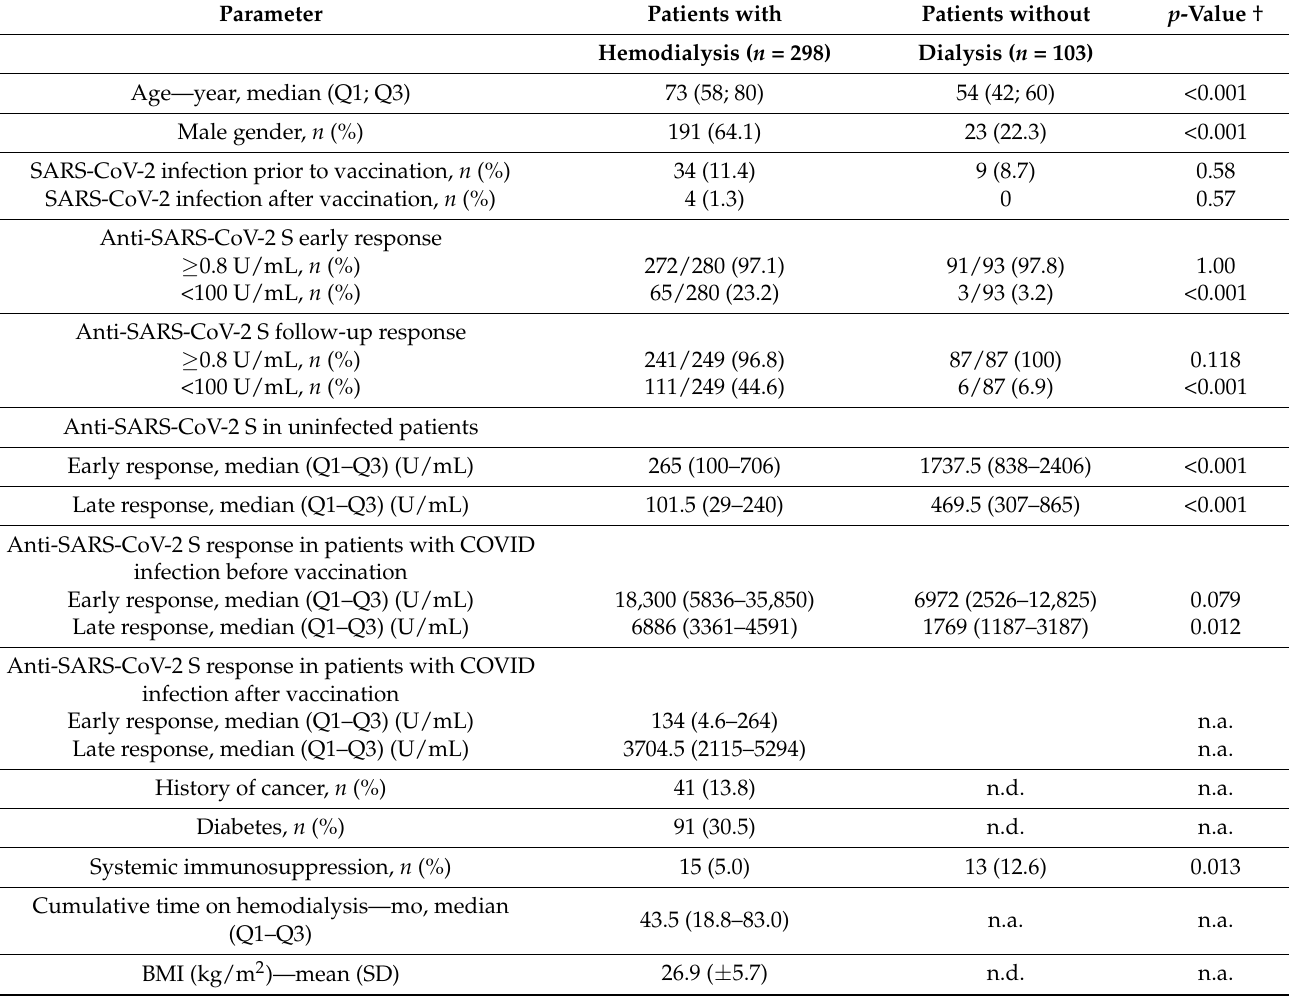
Table 1. Patient